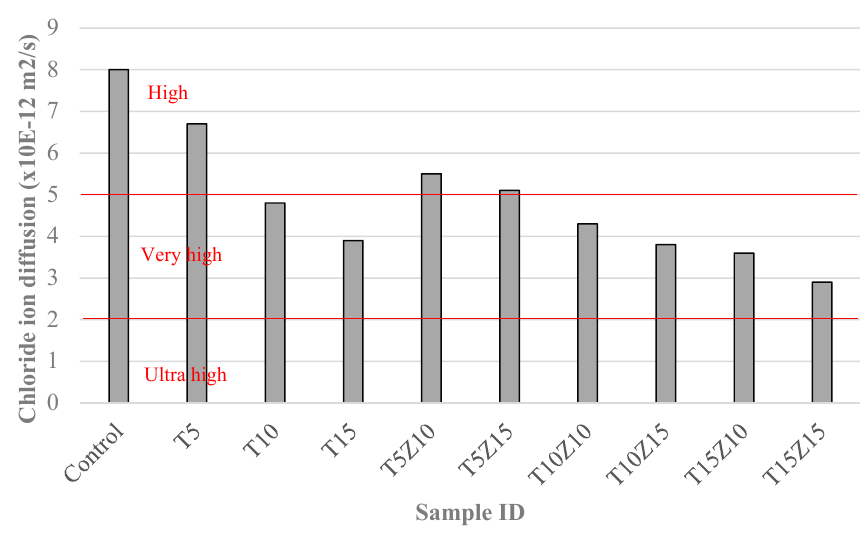
Figure 4. Chloride ion diffusion coefficients of concretes containing tuff and zeolite as compared to the chloride resistance classifications of ASTM 1556.